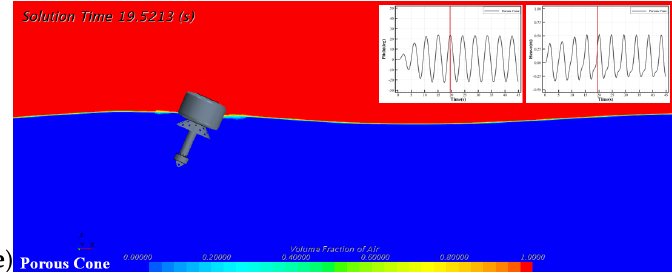
Figure 18. Snapshots of CFD simulations of ( a ) Base, ( b ) Plate, ( c ) Porous Plate, ( d ) Cone and ( e ) Porous Plate models when the 5th plus peak of motion occurs in regular waves, for which the frequency is the same as the pitch natural frequency of the Base model.